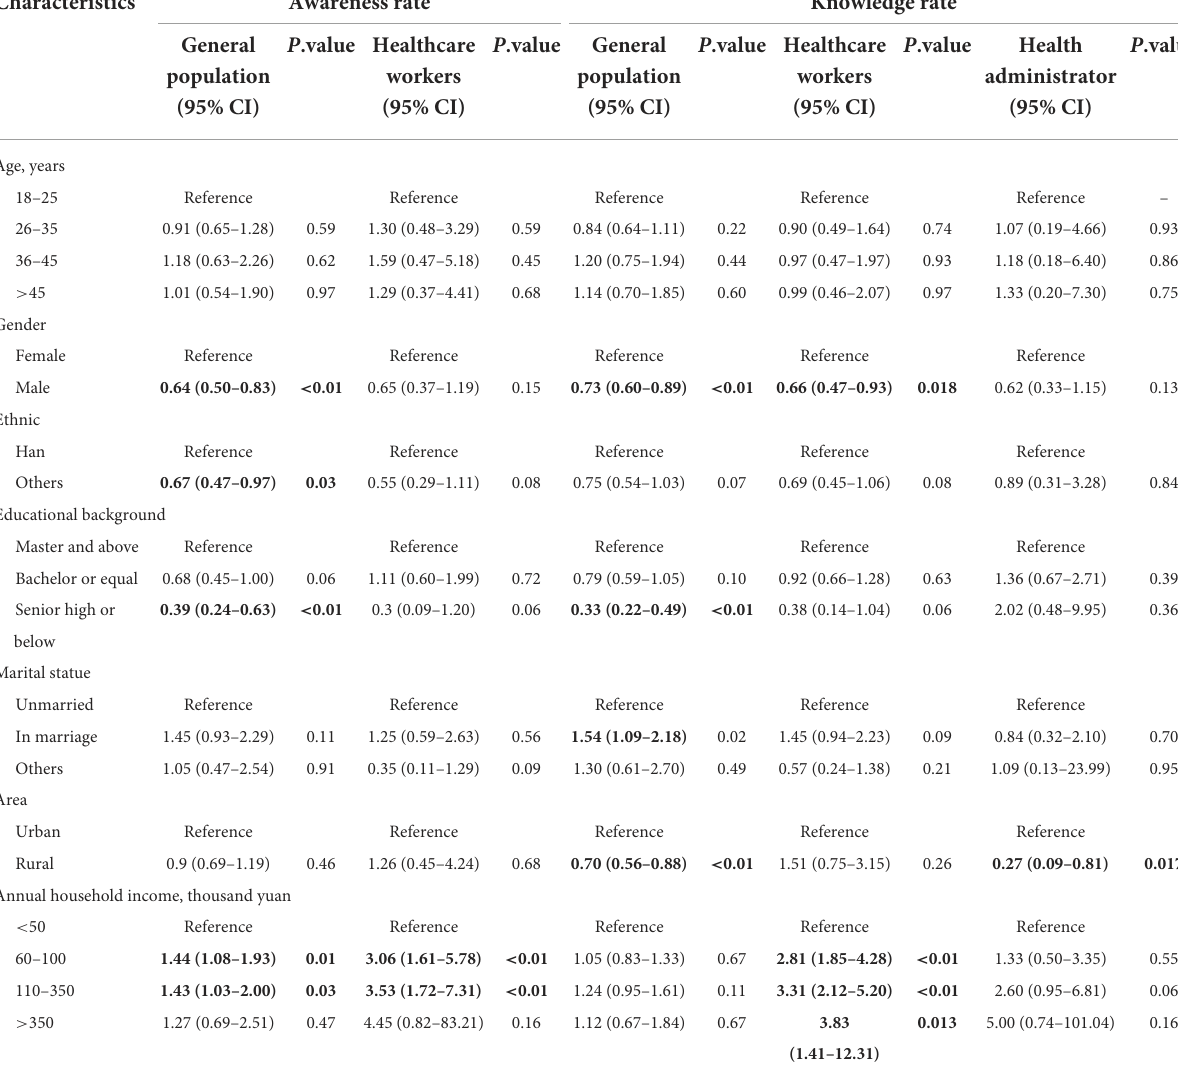
TABLE 2 Socio-demographic factors associated with awareness rate and knowledge rate of influenza vaccines among groups-multivariable logistic regression analysis.